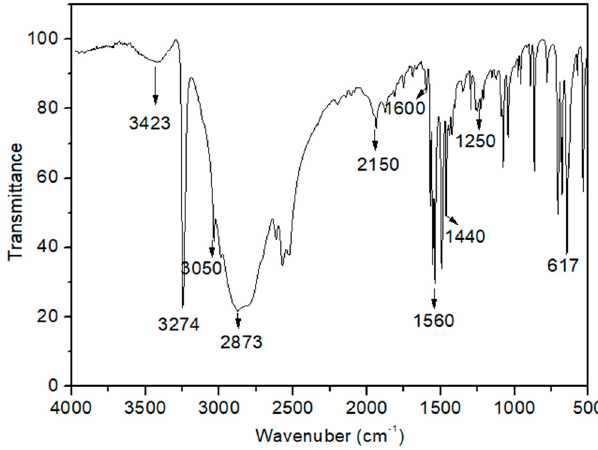
Figure 1. The FTIR spectrum of SAA + .